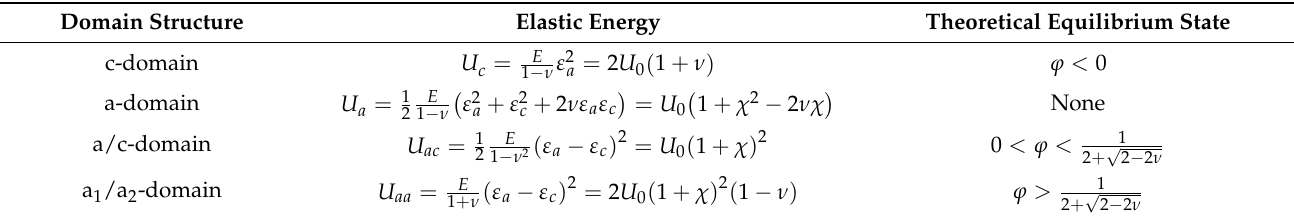
Table 2. Theoretical equilibrium domain states of PTFs.